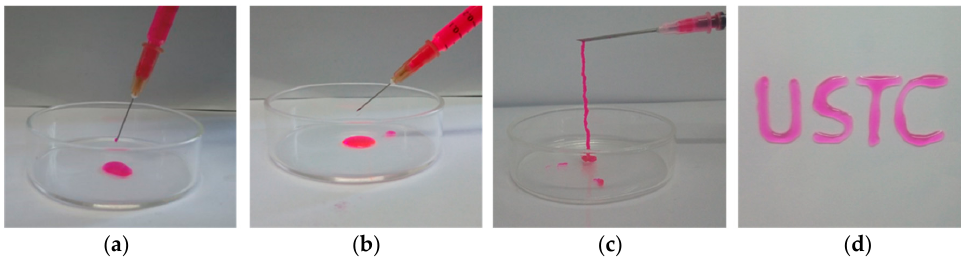
Figure 5. Injection of ADA solution ( a ) and PEG-DTP solution ( b ), injectability ( c ), and printing ability ( d ) of hydrogel samples. (Both compositions were dyed by rhodamine B).